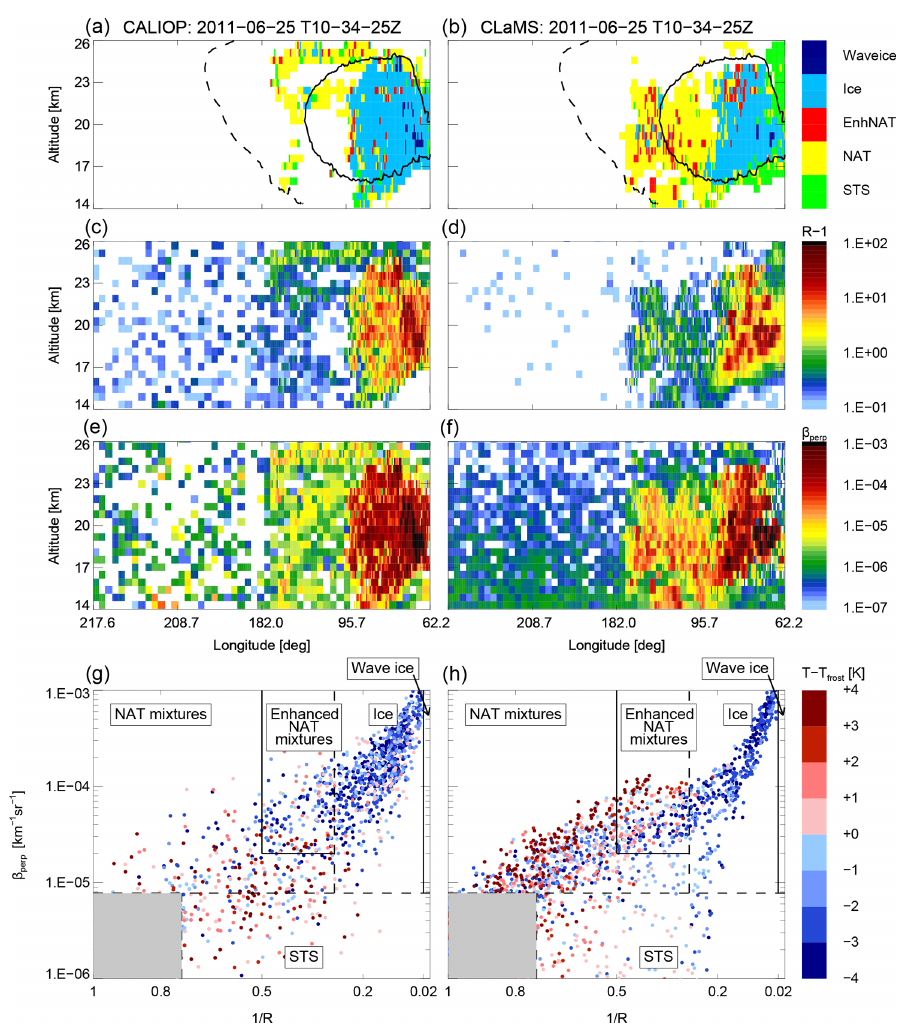
Figure 7. Same as Fig. 3 but for 25 June 2011: CALIPSO orbit track